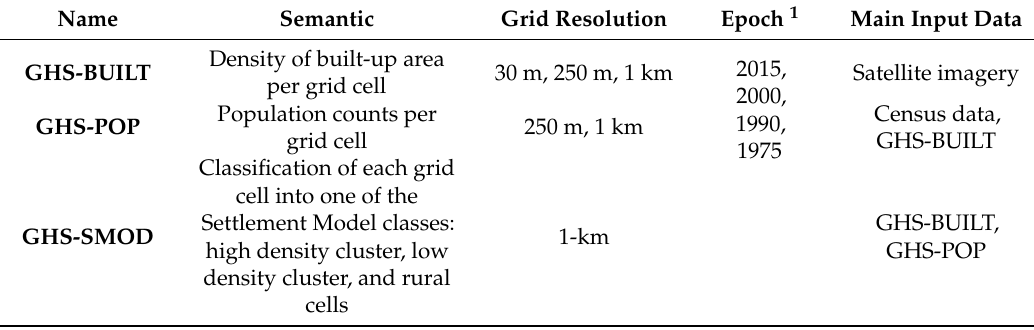
Table 1. Synthesis and features of Global Human Settlement Layer (GHSL)